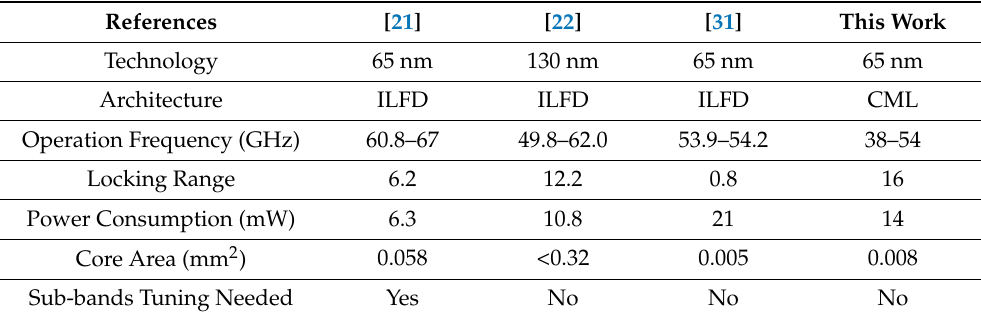
Table 2. Frequency divider performance summary and comparison.